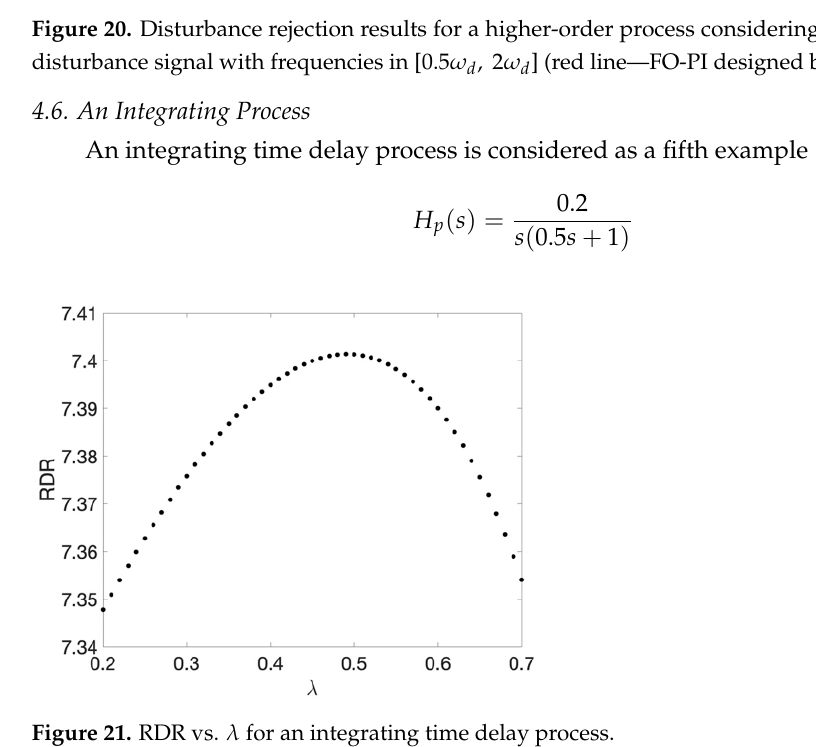
Figure 20. Disturbance rejection results for a higher-order process considering a swept sinusoidal disturbance signal with frequencies in [ 0.5𝜔 (cid:3031) , 2𝜔 (cid:3031) ] ( red line – FO-PI designed by Gude 2010) .